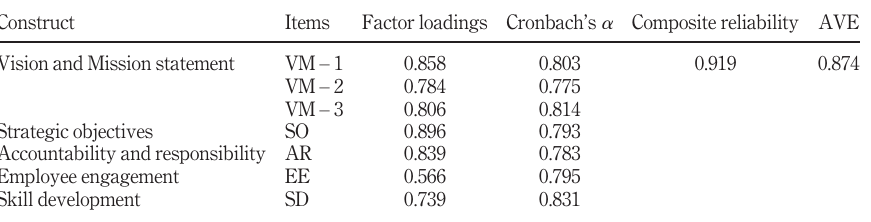
Table 6. Psychometric results of the